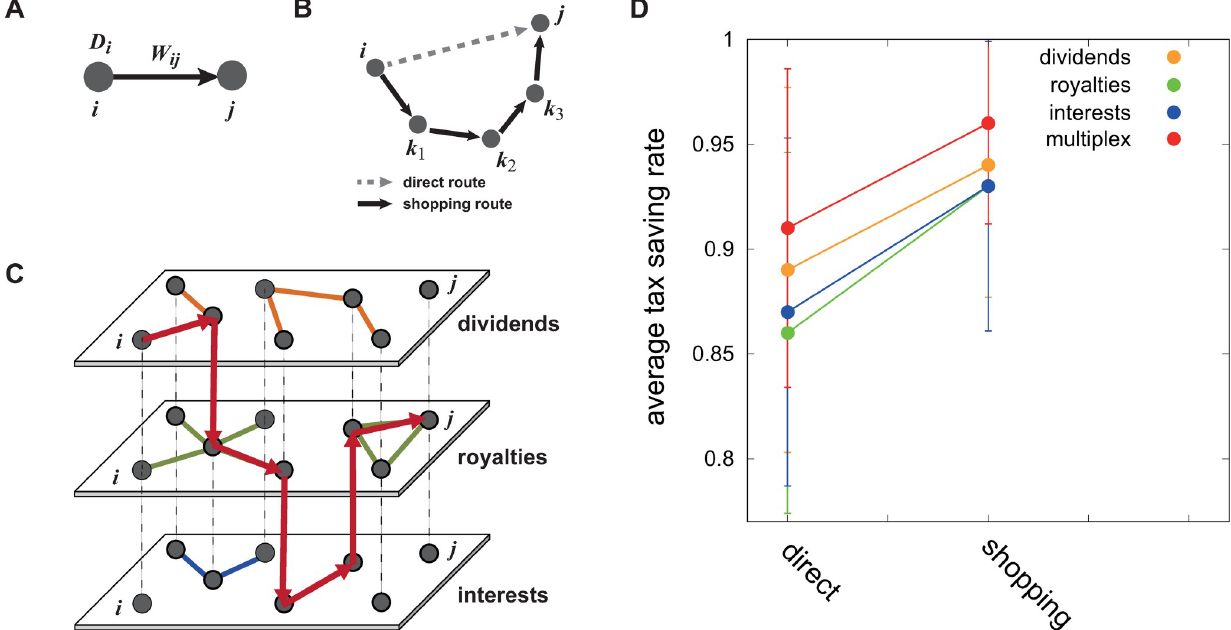
Fig 1. Treaty-shopping routes and the multiplex network framework. (A) The components in a dyadic tax treaty between two countries i and j . D i denotes the domestic tax rate of a country i and W means the withholding tax rates between the two countries. (B) Schematic example of tax-routing ij routes: direct (dotted arrow) and treaty shopping routes (solid arrows). (C) Schematic diagram of multiplex tax treaty networks. Layers 1, 2, and 3 represent different types of income (dividends, royalties, and interest, respectively). In identifying tax-minimizing routes from country i to country j , we see there are no routes between these two countries when the system is considered as as a series of isolated single layers. However, when we consider it as a multiplex network system, we can find the optimal route by crossing layers (depicted in red). Additional tax-minimizing routes may also be available in this multiplex framework of the tax treaty system. (D) Tax-routing centrality value of single layers (dividends, royalties, and interest) and the multiplex network for both route types (direct and shopping).